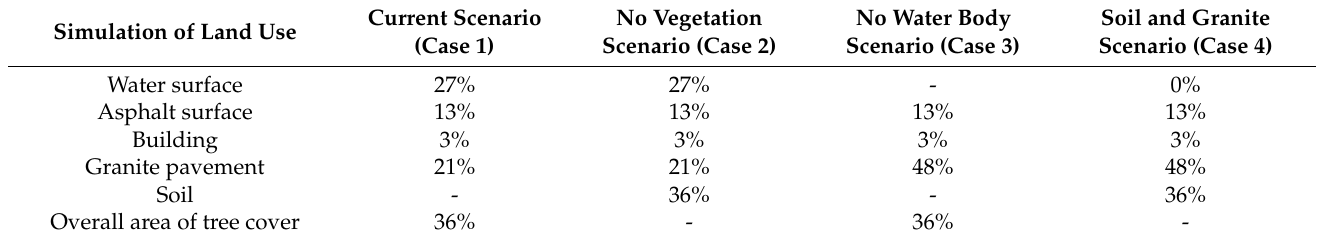
Table 3. Profile alternatives offered to trees.